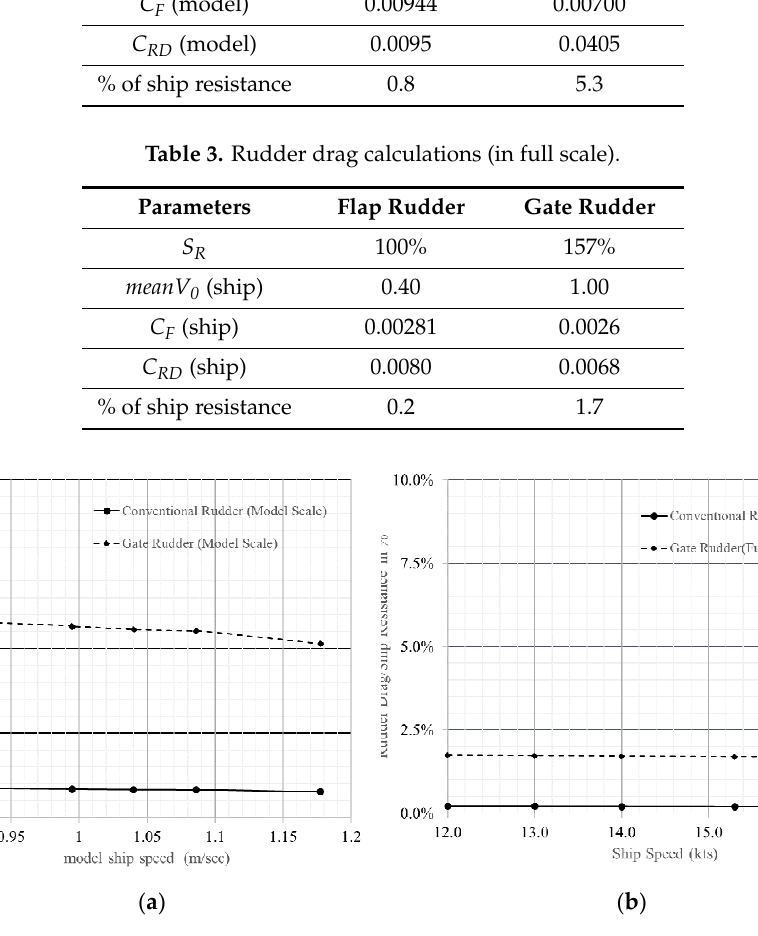
Table 2. Rudder drag calculations (in model scale).